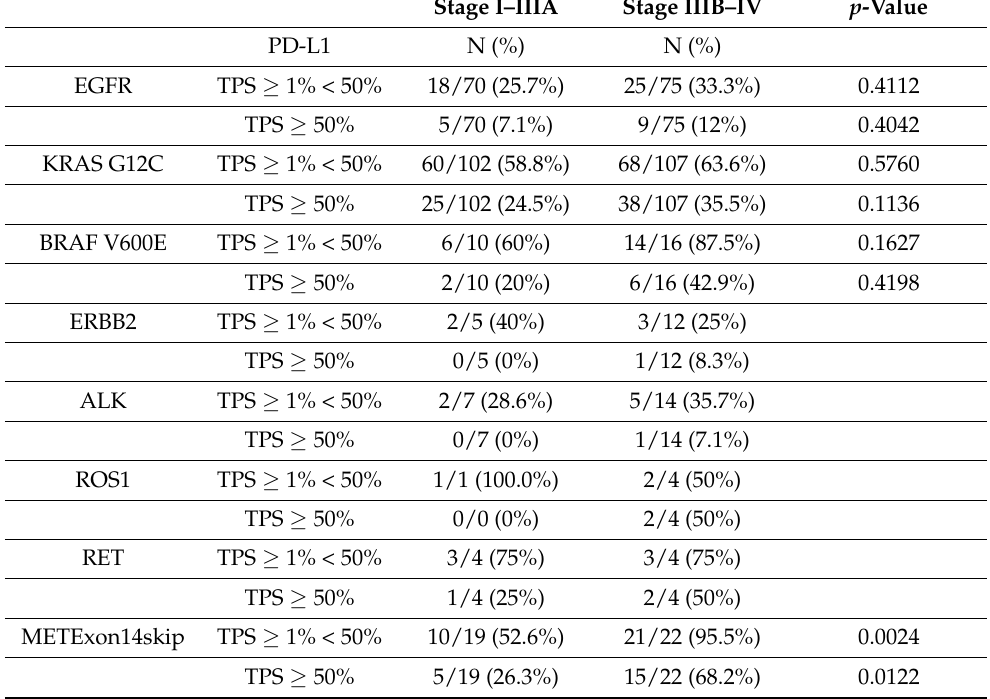
Table 4. Proportion of PD-L1-expressing tumor cells in early-stage vs. advanced-stage NSCLC regarding co-occurring actionable mutations and gene